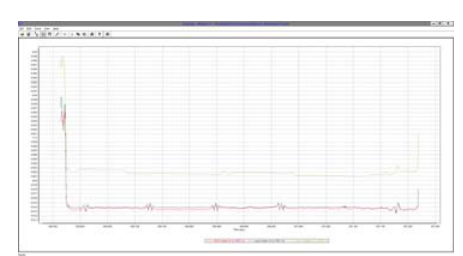
Figure 11: APX-15 UAV trajectory with photo centres - Fryer Dam